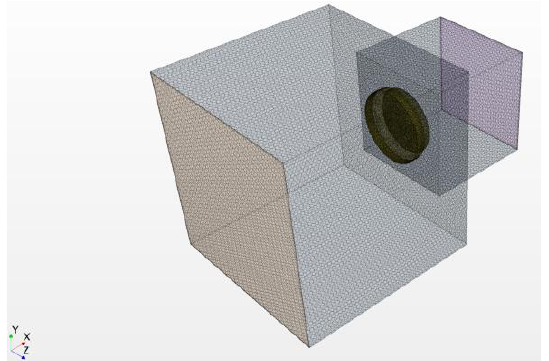
Figure 10. Simulation domain mesh generation.